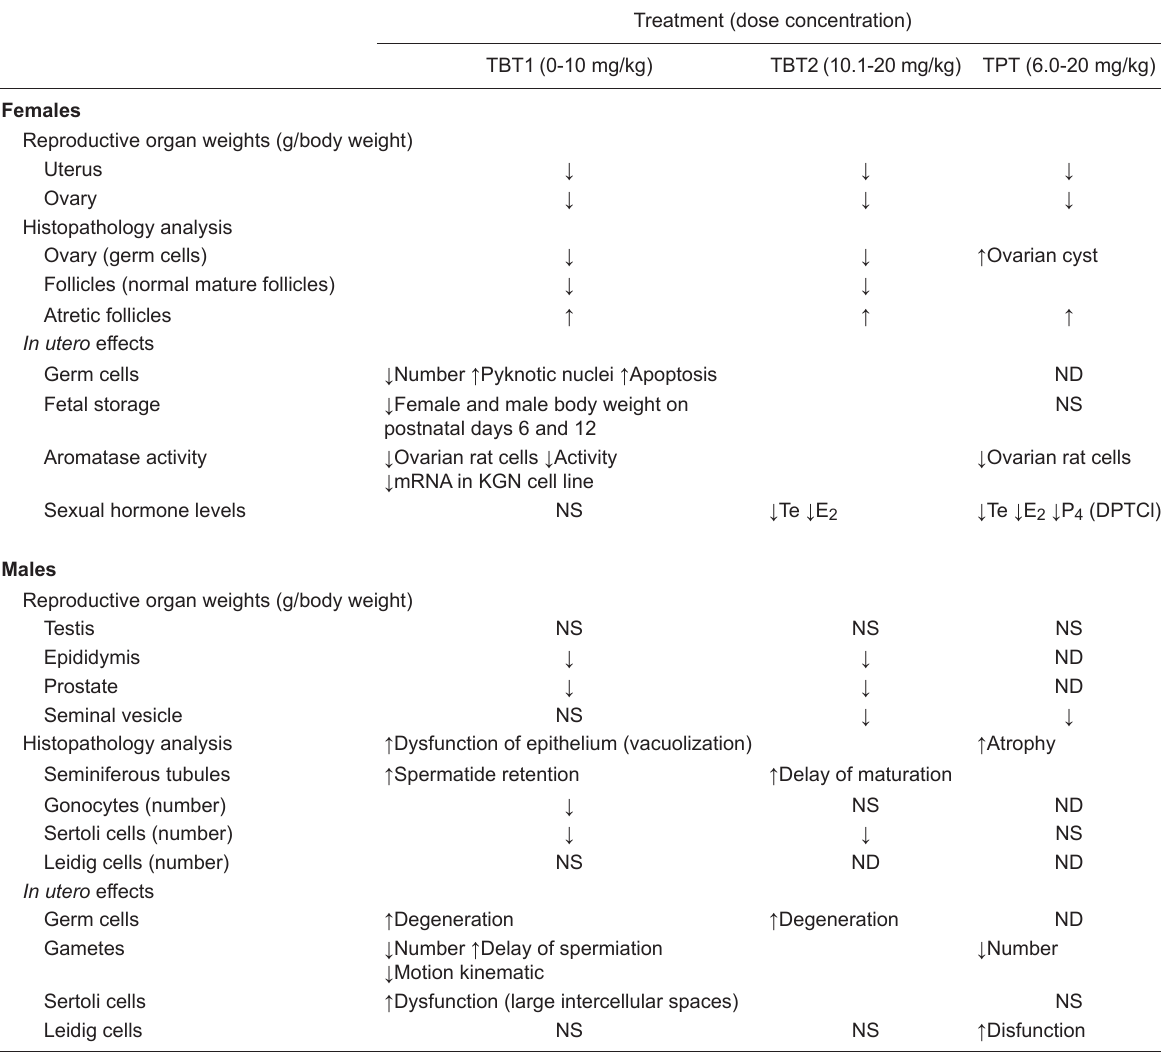
Table 1. Morphofunctional changes induced by triorganotins in the reproductive function of